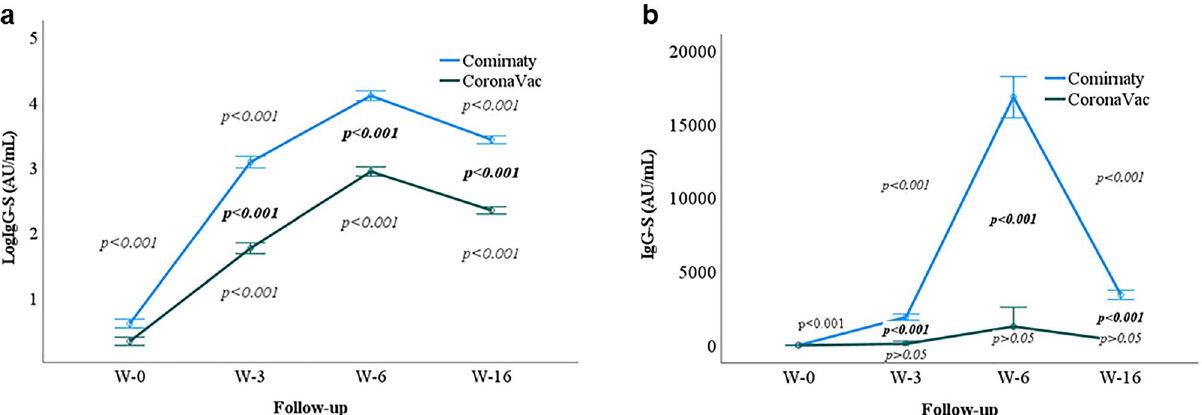
Figure 1. The IgG-S titer of Comirnaty and CoronaVac vaccine recipients at weeks 0, 3, 6, and 16. ( a ) Geometric mean IgG-S titer, ( b ) mean IgG-S titer. Black dotted and dashed lines represent the manufacturer’s medium and high positive cutoff values. W-0, Week zero; W-3, Week three; W-6, Week six, W-16, Week 16. Regular p value indicating the difference between two sampling points. Bolded p values indicating the difference between Comirnaty and CoronaVac at the respective